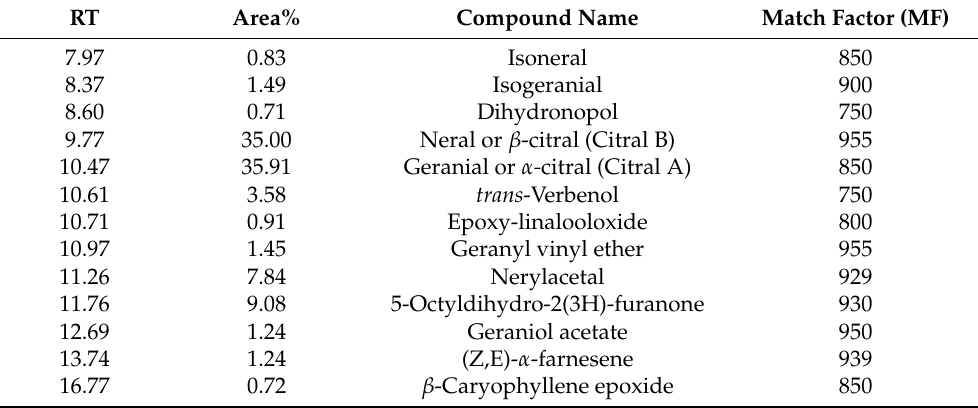
Table 1. Phytochemical screening of essential oil from lemongrass leaves by GC–MS analysis (Figure S1).